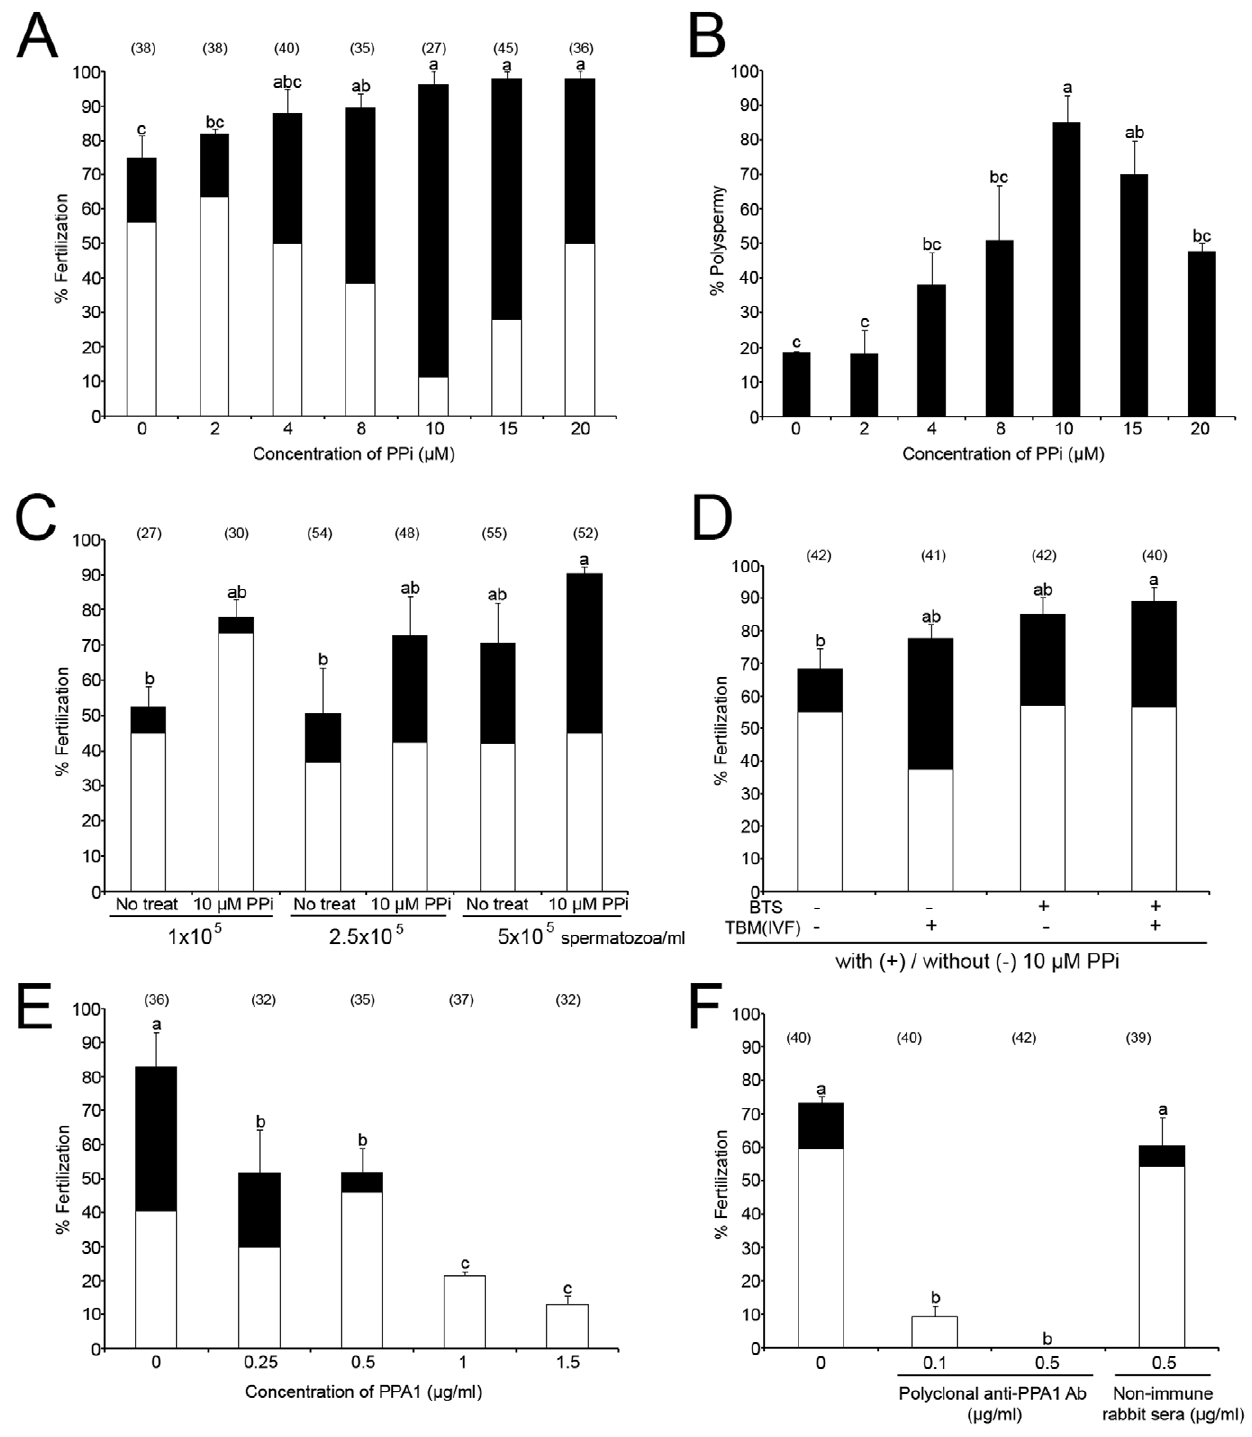
Figure 2. Effect of PPi on total and polyspermic fertilization during porcine IVF. Diagram indicates % monospermic ( % ) and % polyspermic ( & ) fertilization. Values are expressed as the mean percentages of total fertilization 6 SEM. Different superscripts a, b & c in each histogram denote a significant difference at p , 0.05, meaning that column a is significantly different from columns b and c, column b is significantly different from columns a and c, column ab is not significantly different from either a or b, and column bc is not significantly different from columns b and c. Numbers of inseminated ova are indicated in parentheses. (A) Porcine oocytes matured in vitro were inseminated with a standard concentration of 1 6 10 6 spermatozoa/ml, in the presence of ascending concentrations of PPi. Experiments were repeated five times. (B) The polyspermy rates, reflective of sperm fertilizing ability in vitro (same as panel A) dramatically increased in the presence of PPi. (C) Fertilization rates of porcine oocytes inseminated with different concentrations of spermatozoa in the presence/absence of 10 m M PPi. Experiments were repeated three times. (D) Porcine oocytes were inseminated (sperm conc. 5 6 10 5 spermatozoa/ml) with ( + ) or without ( 2 ) 10 m M PPi in TBM, using spermatozoa stored with ( + ) or without ( 2 ) PPi in BTS. Experiments were repeated three times. (E) Effect of extrinsic PPA1 enzyme on porcine IVF. Oocytes were inseminated with